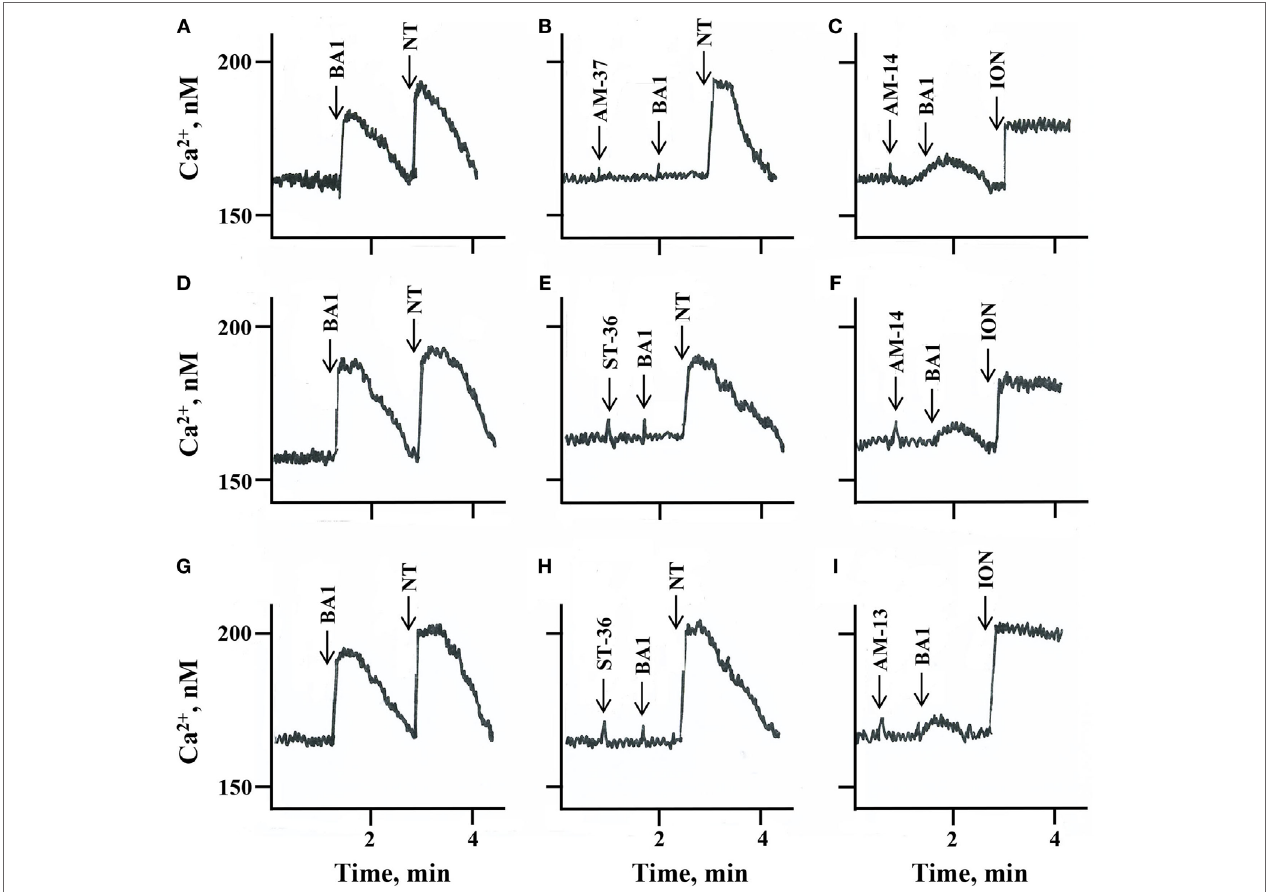
FigUre 2 | Cytosolic Ca 2 + . The ability of (a) 10 nM bombesin agonist 1 (BA)1 and 10 nM neurotensin (NT), (B) 30 µM AM-37 followed by 10 nM BA1 and 10 nM NT, and (c) 30 µM AM-14 followed by 10 nM BA1 and 5 µg/ml ionomycin (ION) to increase cytosolic Ca 2 + was determined as a function of time after the addition to NCI-H1299 cells transfected with BB 1 R. The ability of (D) 10 nM BA1 and 10 nM NT, (e) 30 µM ST-36 followed by 10 nM BA1 and 10 nM NT, and (F) 30 µM AM-14 followed by 10 nM BA1 and 5 µg/ml ION to increase cytosolic Ca 2 + was determined as a function of time after the addition to NCI-H1299 cells transfected with BB 2 R. The ability of (g) 10 nM BA1 and 10 nM NT, (h) 30 µM ST-36 followed by 10 nM BA1 and 10 nM NT, and (i) 30 µM AM-13 followed by 10 nM BA1 and 5 µg/ml ION to increase cytosolic Ca 2 + was determined as a function of time after the addition to NCI-H1299 cells transfected with bombesin receptor subtype-3. This experiment is representative of three others.